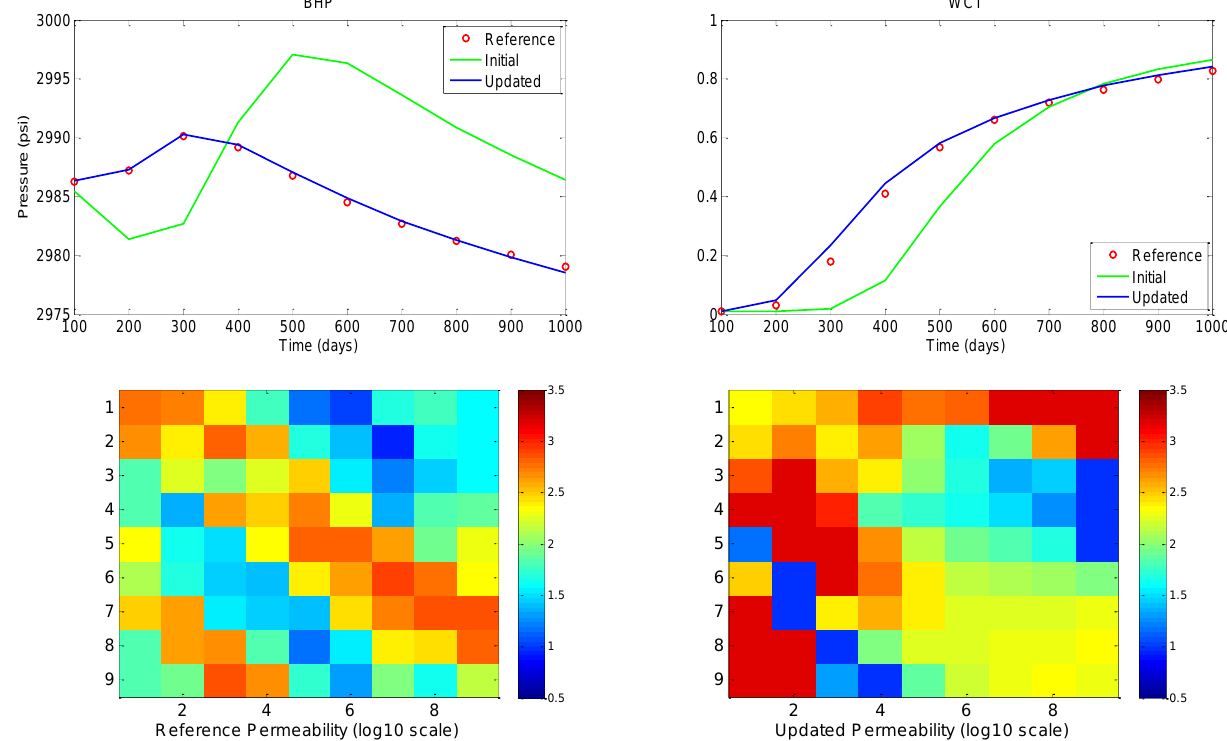
Figure 7—Model calibration results (BHP and WCT).